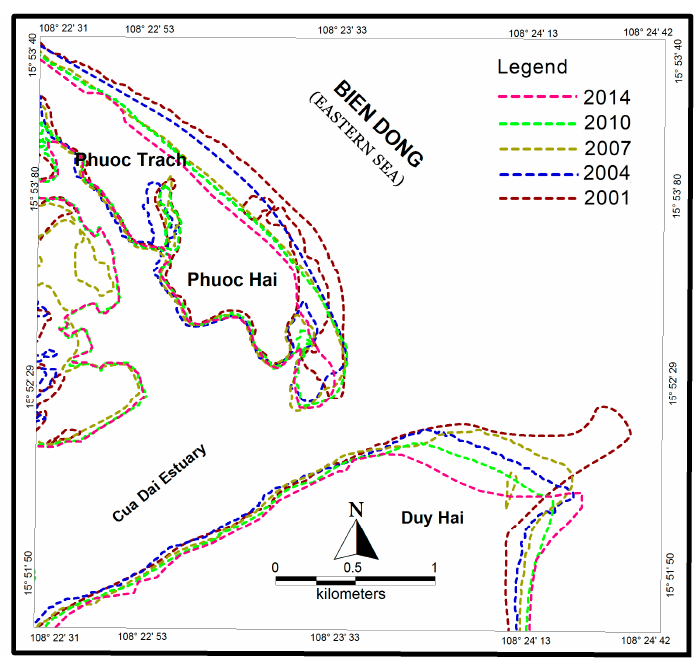
Figure 5. The historical shoreline morphological changes of the Cua Dai estuary between 2001 and 2014.